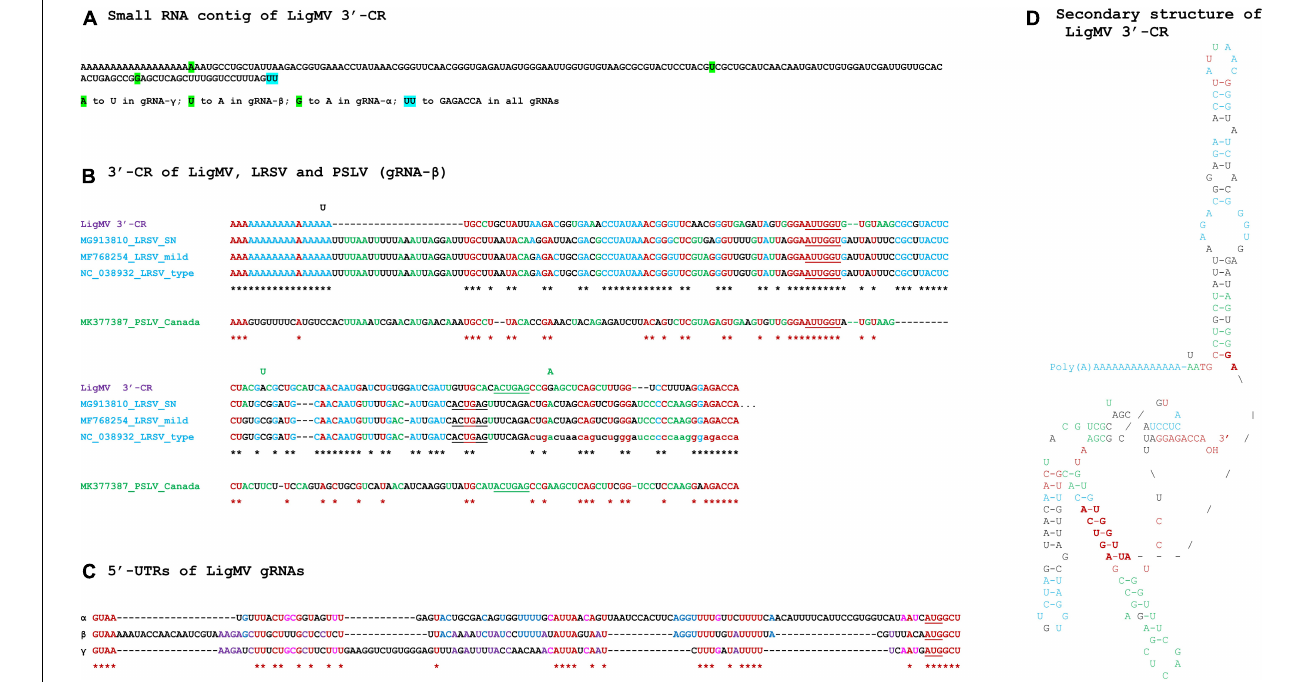
FIGURE 2 | Ligustrum mosaic virus (LigMV) 3 (cid:48) -common region (CR) and 5 (cid:48) -UTR sequences and comparison of the 3 (cid:48) -CRs of LigMV and other hordeiviruses. (A) Sequence of the small RNA contig representing the LigMV 3 (cid:48) -CR. The nucleotide positions that distinguish the 3 (cid:48) -CRs of three genomic RNA (gRNA) segments ( α , β , γ ) are highlighted in green, with the nucleotide substitutions indicated below the contig sequence. The last two nucleotides of the contig (UU, highlighted in cyan) are not confirmed by 3 (cid:48) -RACE analysis and, based on this analysis, are replaced with GAGACCA in all three gRNAs. (B) Alignment of the 3 (cid:48) -CRs of LigMV (isolate CH), lychnis ringspot virus (LRSP) isolates SN (NCBI accession: MG913810), mild (MF768254) and type (NC_038932), and poa semilatent virus (PSLV) isolate Canada (MK377387). The lowercase nucleotides in LRSV type strain—missing in the reference sequence NC_038932—are added according to Solovyev et al. (1996). The nucleotides identical in all the viral species and isolates are shown in red and indicated in red asterisks’ consensus. The nucleotides identical between LigMV and all the LRSV isolates are shown in cyan and the LigMV-LRSV consensus sequence is indicated with black asterisks. The nucleotides identical only between LigMV and PSLV or only between PSLV and LRSP are shown in green. The nucleotides involved in formation of ascending and descending arms of the central helix of the tRNA-like structure are underlined. The nucleotide changes distinguishing LigMV gRNAs (A) are shown above the alignment at corresponding positions. (C) Comparison of the 5 (cid:48) -untranslated regions (UTRs) of LigMV gRNAs α , β , and γ . The identical nucleotides shared by all the three gRNA segments are shown in red and indicated with asterisks. The additional nucleotides identical only between α and β , or α and γ , or β and γ , are shown in blue, pink, and purple, respectively. The AUG start codon of each gRNA is underlined. (D) Tentative secondary structure of the LigMV 3 (cid:48) -CR sequence. For its comparison with tentative secondary structures of 3 (cid:48) -CRs of PSLV, LRSV, and BSMV, see Supplementary Figure 2 . The structural elements identical to those found either in LRSV or PSLV or in both viruses are highlighted in cyan, green, and red, respectively. Bold red indicates the two primary sequence elements GGAAUUGGU and ACUGA involved in formation of the central helix of the tRNA-like structure and its connection to the hairpin stem, which are also conserved in the predicted tRNA-like structure of BSMV ( Supplementary Figure 2B ). The nucleotide changes distinguishing LigMV gRNAs (A) and shown at the corresponding positions do not destabilize any secondary structure